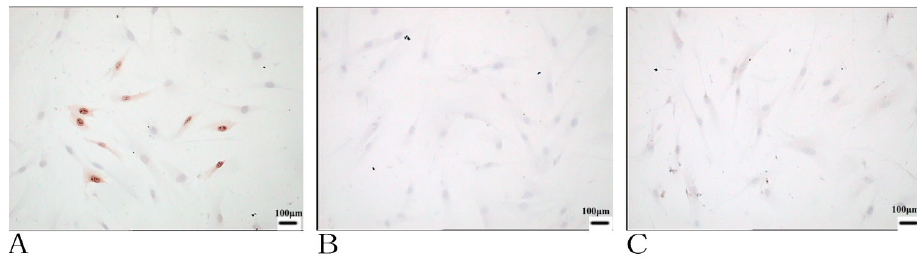
Figure 4. Evaluation of apoptosis in cultured PDL fibroblasts using the TUNEL method. Forty-eight hours after culture, apoptosis was detected using an apoptosis detection kit after fixation. Cells with dark brown nuclei were considered apoptotic. The number of apoptotic cells increased in the AGE-BSA group ( A ) compared with BSA treatment ( B ) and the control ( C ). Magnification, 400 6 .